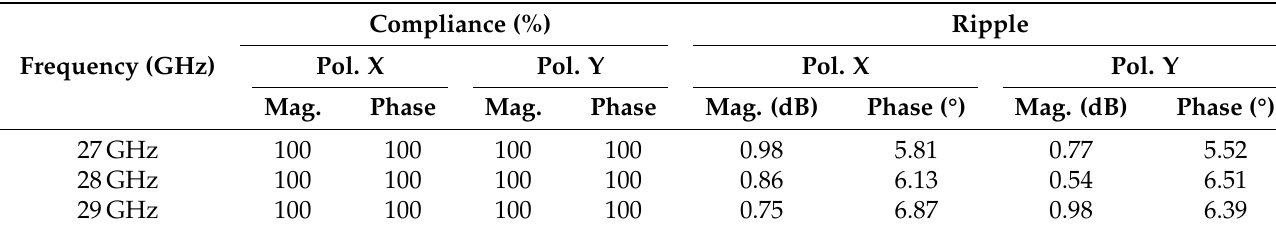
Table 2. Performance of the reflectarray after the wideband multi-frequency optimization at a plane 0.5m away from the antenna. Compliance (%) indicates percentage of surface in Ω 1 that complies with specifications.